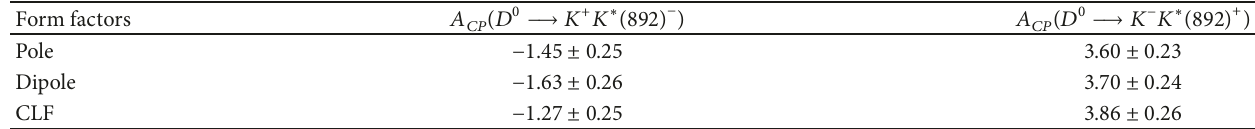
Table 3: 𝐶𝑃 asymmetries (in unit of 10 −5 ) of 𝐷 0 󳨀→ 𝐾 + 𝐾 ∗ (892) − and 𝐷 0 󳨀→ 𝐾 − 𝐾 ∗ (892) + predicted by the FAT approach with pole, dipole, and CLF models adopted. The uncertainties in this table are mainly from decay constants.